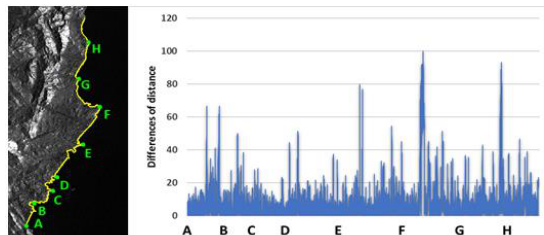
Figure 10. Differences of distance between the reference coastline and manually digitized coastline The mean, standard deviation and median values between the final results and the reference vector data and between the initial results from RASAT and final result from SAR data are given in Table 3. Table 3.Quality assessment of the results Reference Data - Result